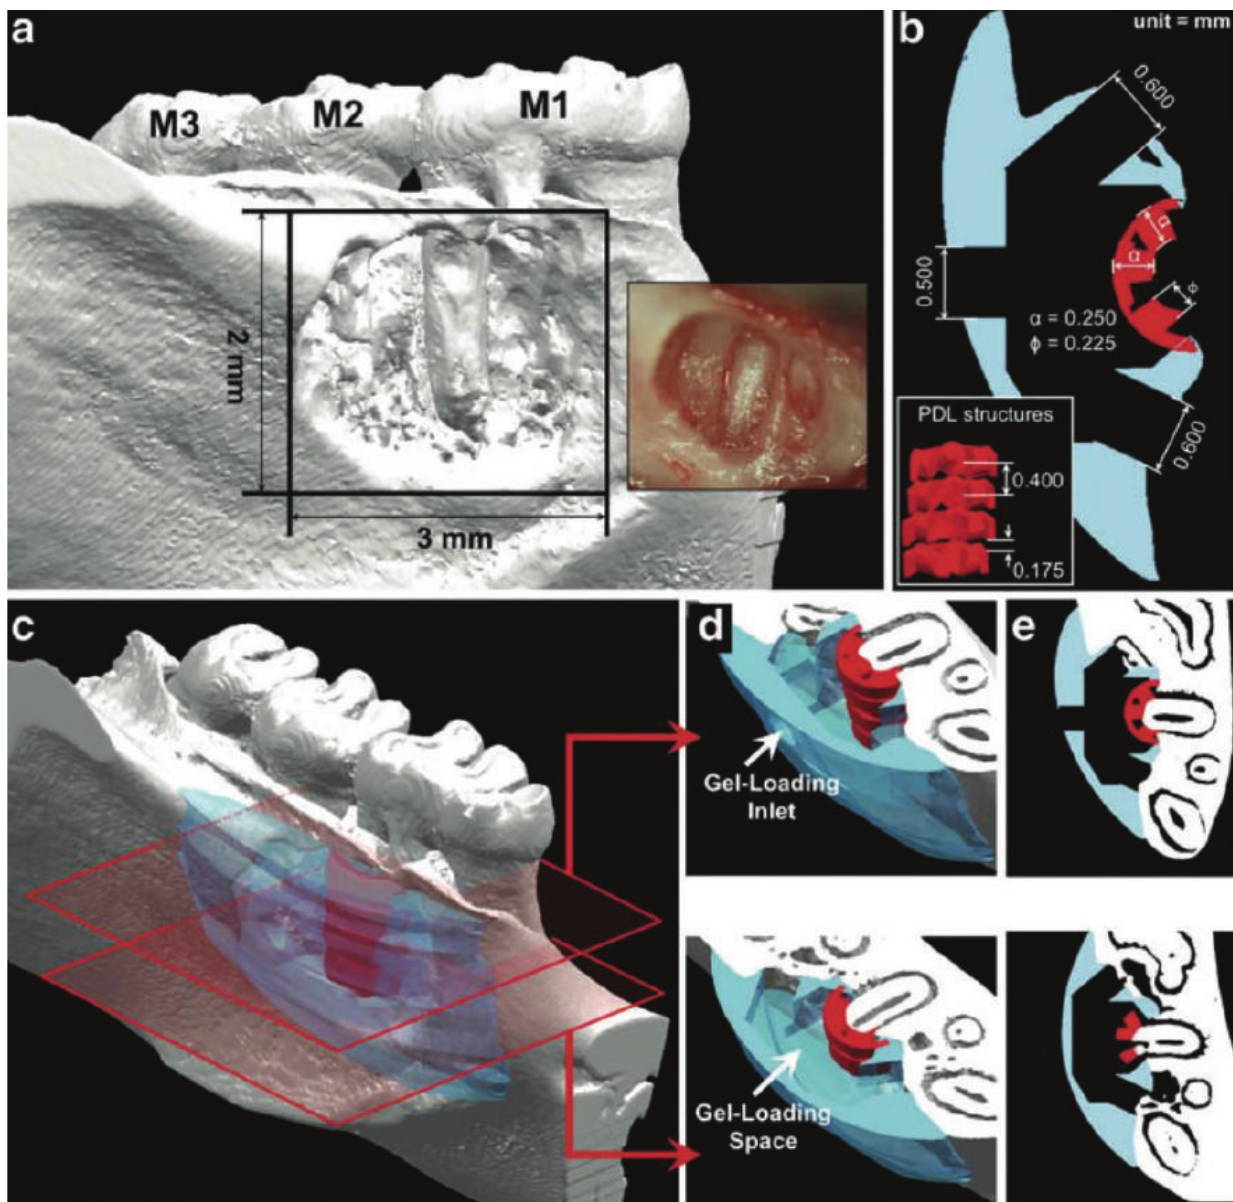
Figure 1: Multiphasic scaffold aimed at multiple tissue regeneration (periodontal ligament, cementum, and alveolar bone). Courtesy of Park et al., 2012